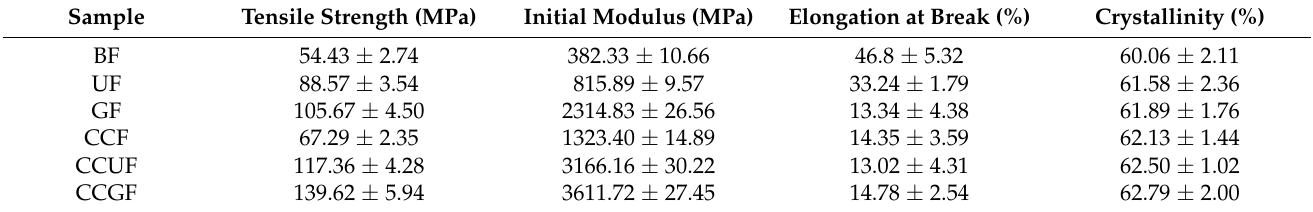
Table 2. Tensile strength and crystallinity of regenerated cellulose fibers with or without additives.